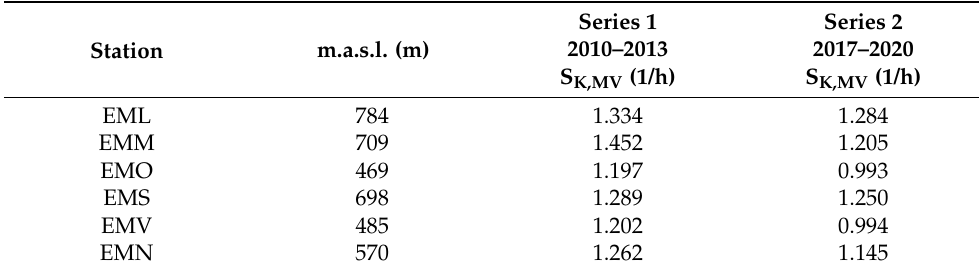
Table 1. Presents the entropies of the meteorological variables (MVs) for the two periods (2010–2013 and 2017–2020) according to the same heights.